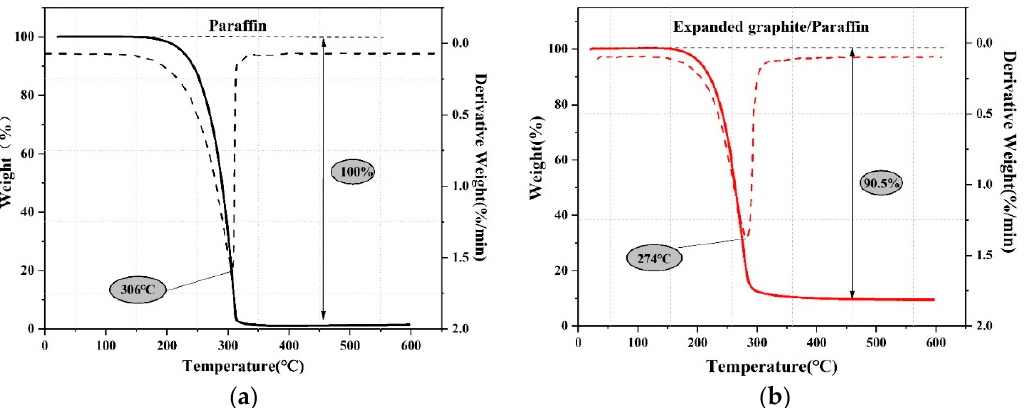
Figure 6. TGA (Thermal Analysis System) and DTG (Derivative Thermogravimetric Analysis) curves of ( a ) paraffin and ( b ) expanded graphite/paraffin.